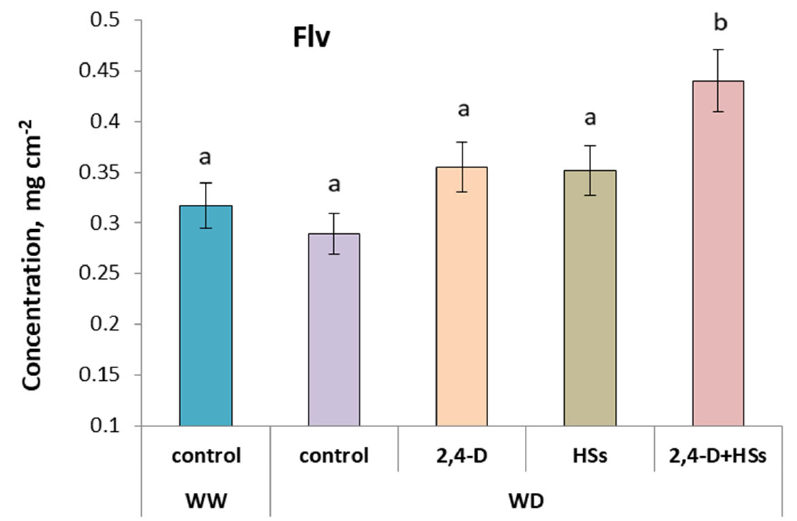
Table 9. ANOVA test for root ABA content followed by Duncan test. Values in the cells correspond to p for the difference between the mean values; p ≤ 0.05 is marked with *; p ≤ 0.01—with ** for control plants untreated with either bacteria or HSs and plants grown under water deficit (WD): control, plants treated with Pseudomonas plecoglossicida 2,4 ‐ D (2,4 ‐ D), humic substances (HSs) and their combinations (2,4 ‐ D + HSs). Figure 5. Concentration of flavonoids (Fvl) in leaves of wheat plants 7 days after treatment with Pseudomonas plecoglossicida 2,4 ‐ D (2,4 ‐ D), humic substances (HSs) and their combinations (2,4 ‐ D + HSs) under well ‐ watering (WW) and in water deficit (WD) conditions. Statistically different means are marked with different letters, p ≤ 0.05, n = 30 (ANOVA followed by Duncan’s test). Table 7. ANOVA test for flavonoids content followed by Duncan test. Values in the cells correspond to p for the difference between the mean values; p ≤ 0.05 is marked with *; p ≤ 0.01—with ** for control plants untreated with either bacteria or HSs and plants grown under water deficit (WD: control, plants treated with Pseudomonas plecoglossicida 2,4 ‐ D (2,4 ‐ D), humic substances (HSs) and their combinations (2,4 ‐ D + HSs).